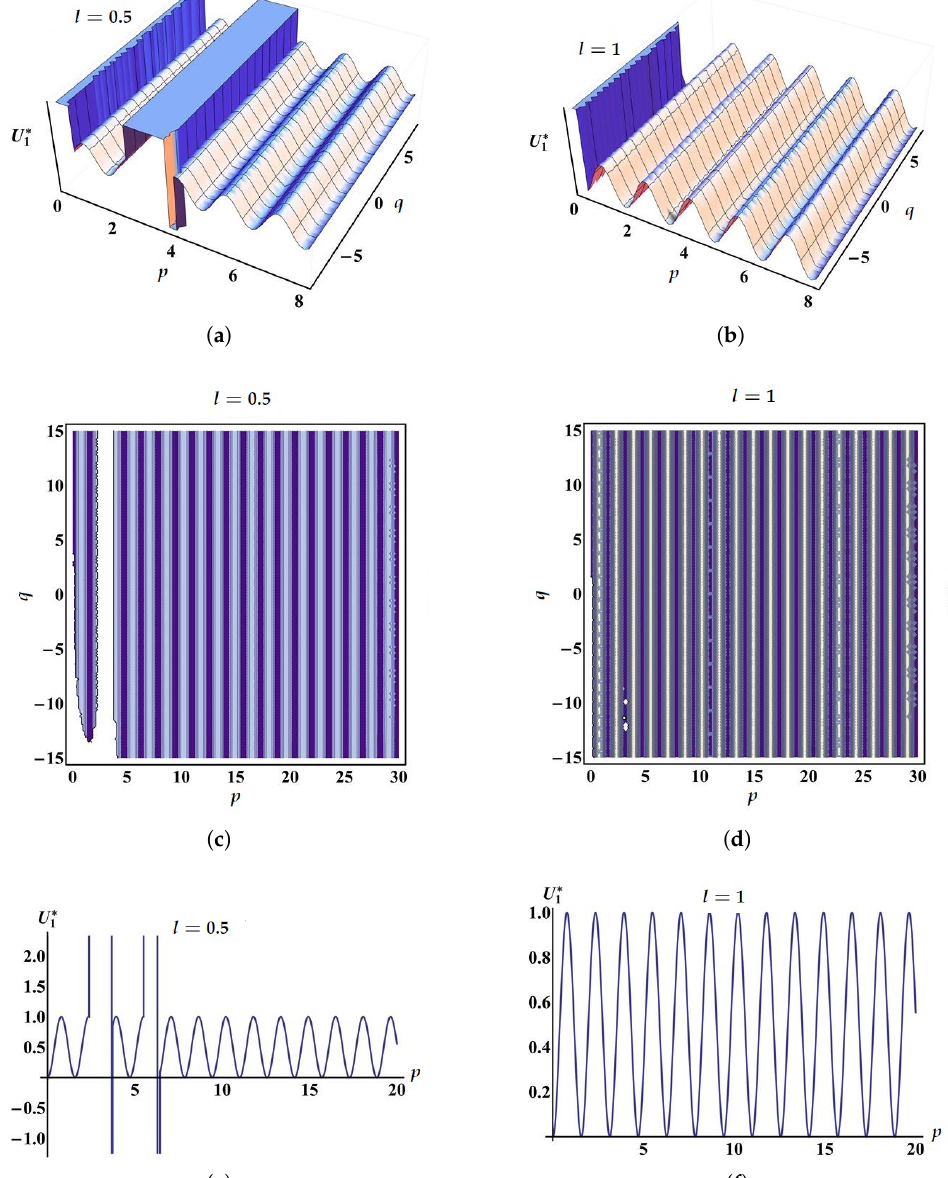
Figure 2. Under the noise influence, ( a – f ) are three-dimensional (contour) (two-dimensional) profiles for the wave solution (45), when l = 0.5 and l = 1,